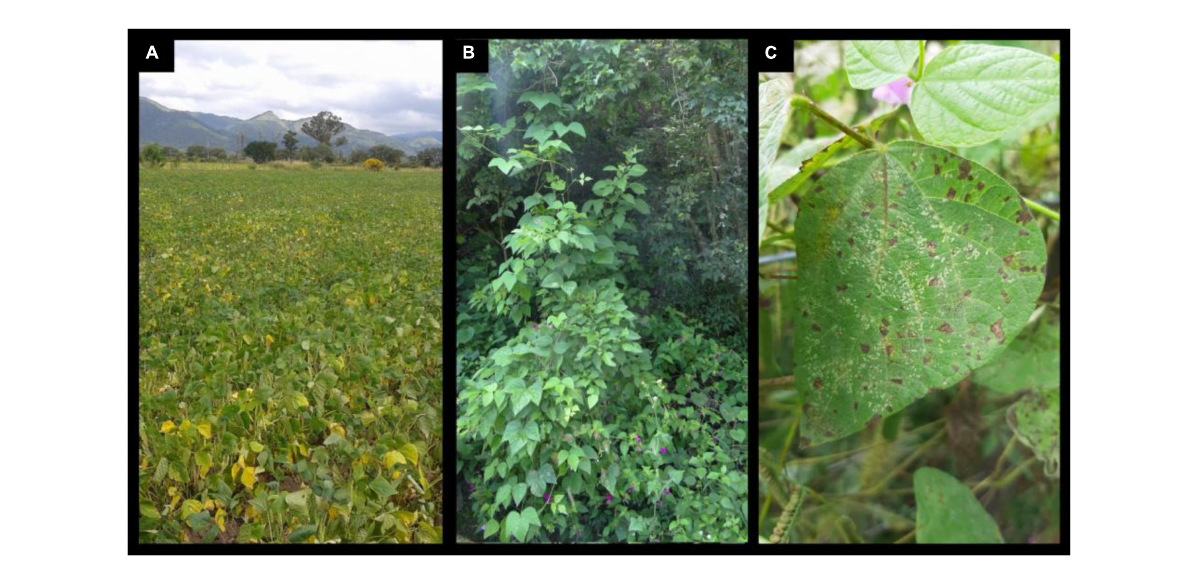
FIGURE2 (A) Plants showing angular leaf spot symptoms in a common bean field in northwestern Argentina. (B) Argentinean wild bean exhibiting its characteristic indeterminate growth habit. (C) Wild bean showing angular leaf spot symptoms.